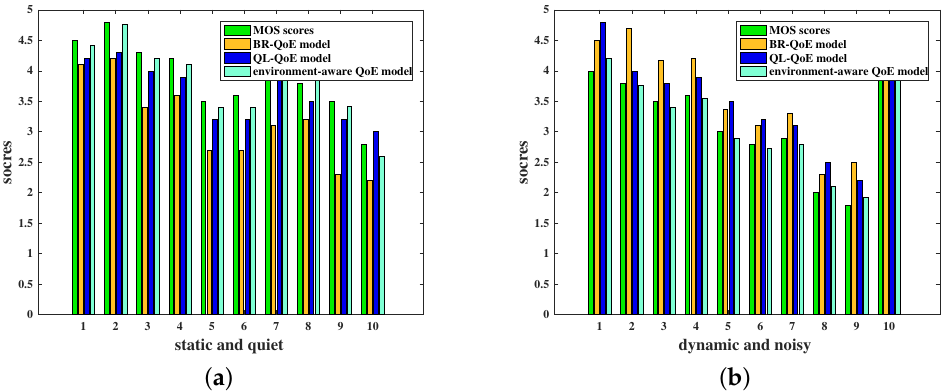
Figure 4. Ten groups of MOS score results in different environments. ( a ) Static and quiet environment. ( b ) Dynamic and noisy